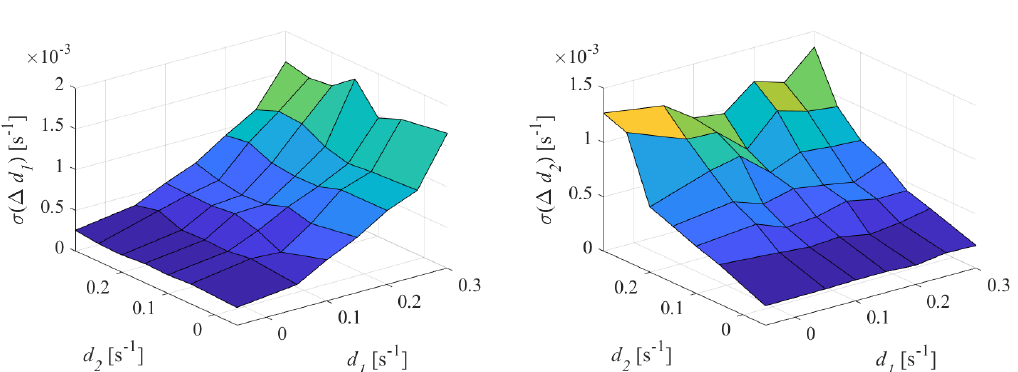
Figure 9. Standard deviation of ∆ d versus damping coefficients obtained in numerical tests with noise and quantization; results for frequency f 1 ( on the left ) and f 2 ( on the right ).